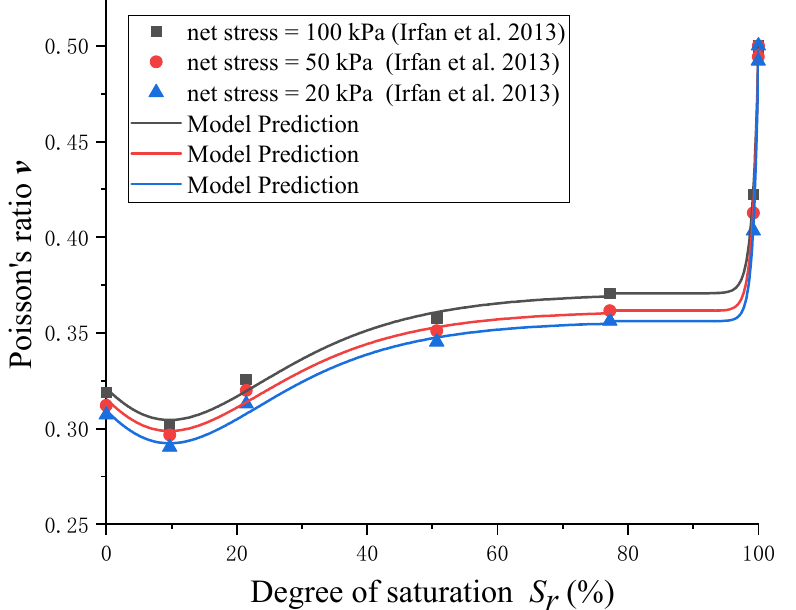
Figure 11. Variation curve and model prediction of Poisson’s ratio for Edozaki sand [49].